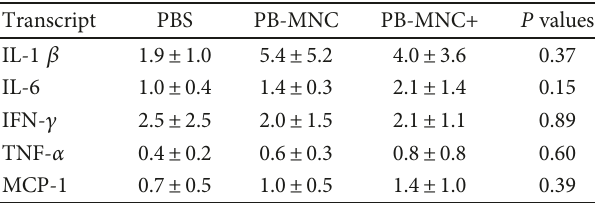
Table 3: Relative proin fl ammatory cytokines transcript levels in treated and untreated mice at D3 ( N = 5 – 7 ).